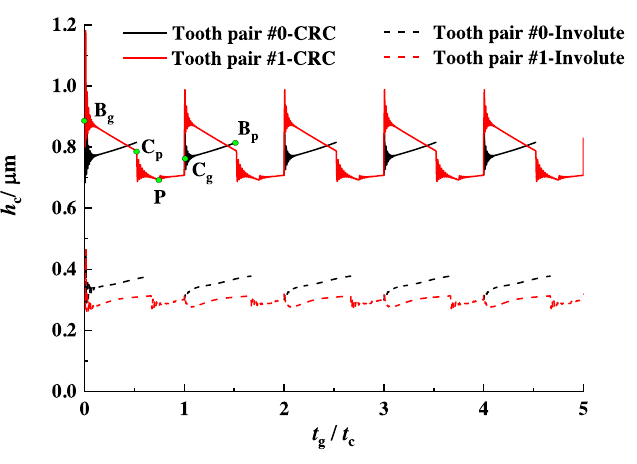
Fig. 15. Entrainment speed.